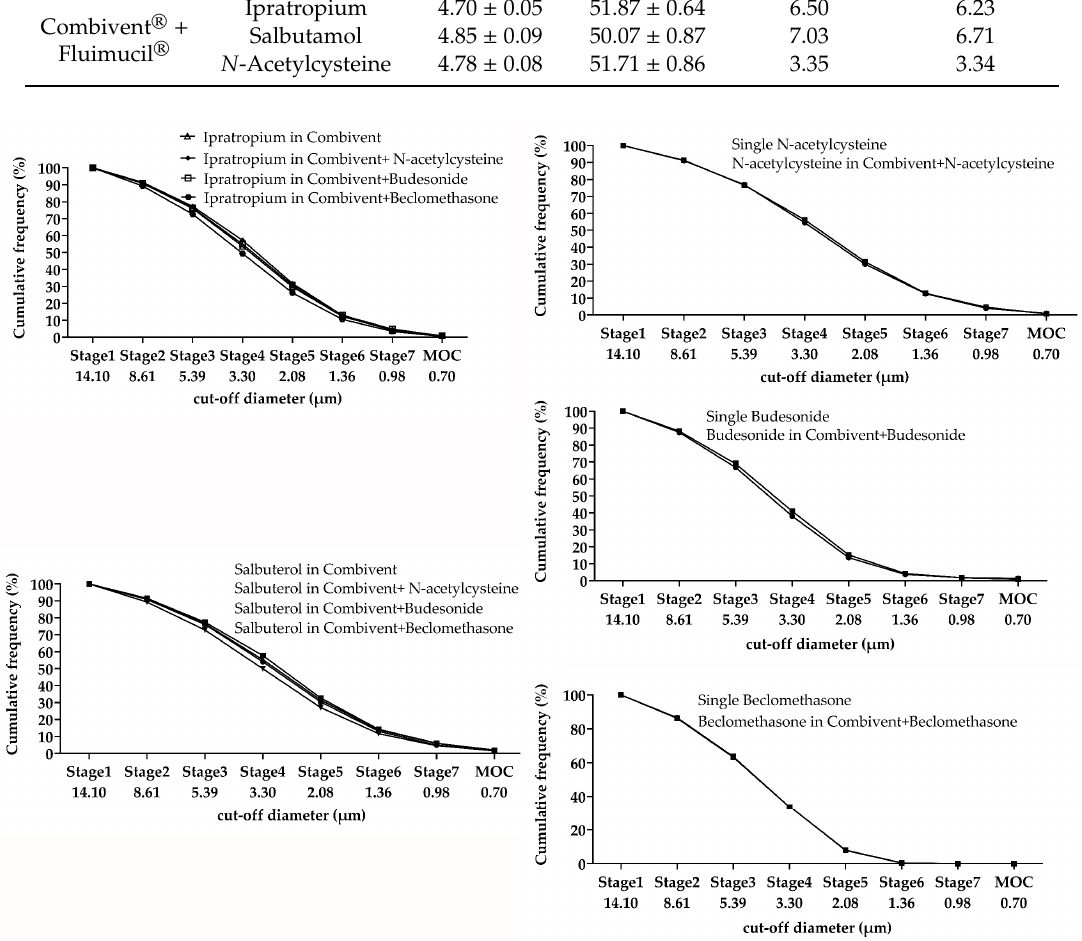
Figure 2. Cumulative frequency curve of single and mixed inhalation solutions.